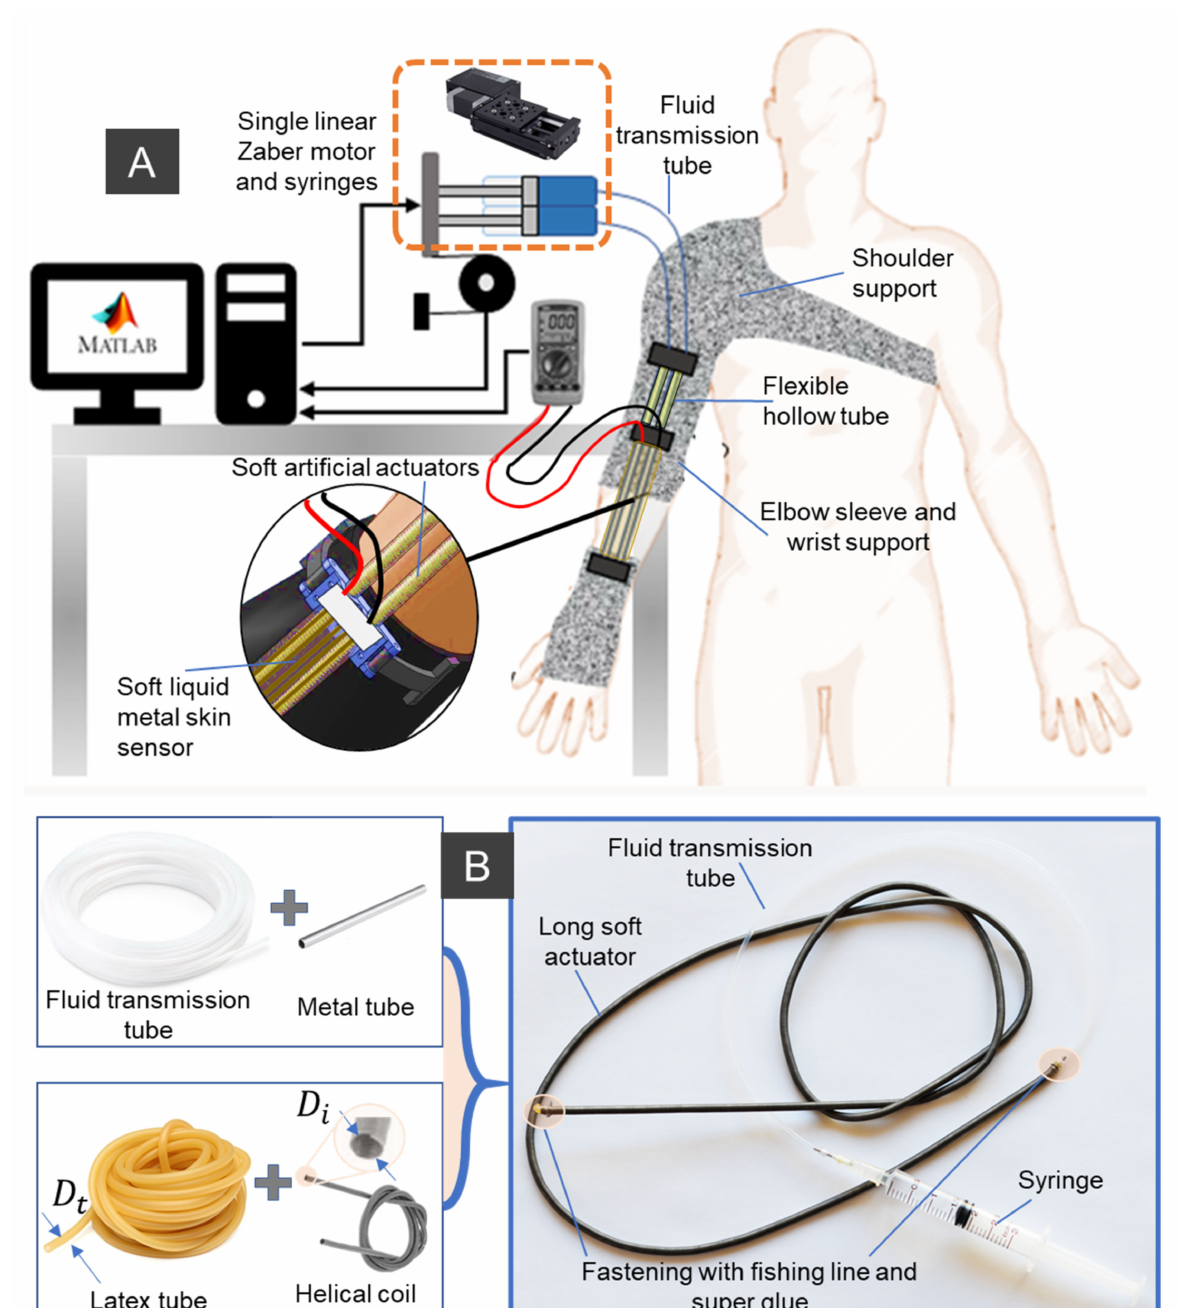
Figure 1. Soft wearable fabric sleeve for upper limb assistance. ( A ) Conceptual design with integrated components, including soft liquid metal-based skin sensor, soft artificial actuators and their guide tube, elbow support, wrist support, and shoulder support. It is noted that each muscle is connected to a miniature syringe, and the array of these muscles is driven by a single Zaber DC motor. ( B ) Fabrication process for the high aspect ratio soft actuator and its prototype (length/outer diameter = 1000 mm/3.15 mm